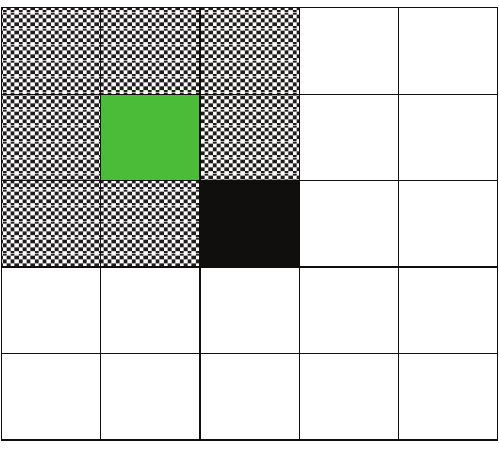
Figure 2: The possible calculating neighbors of an occupant.